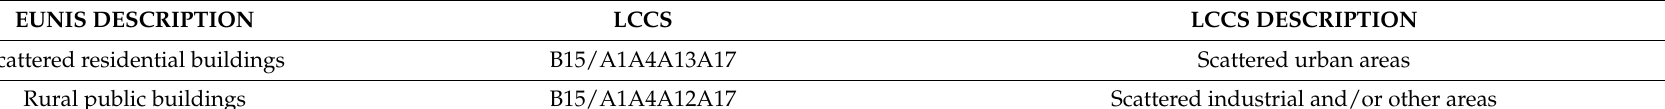
Table A1. Reference table showing the complete list of habitat types in EUNIS and of LC classes in LCCS with the corresponding